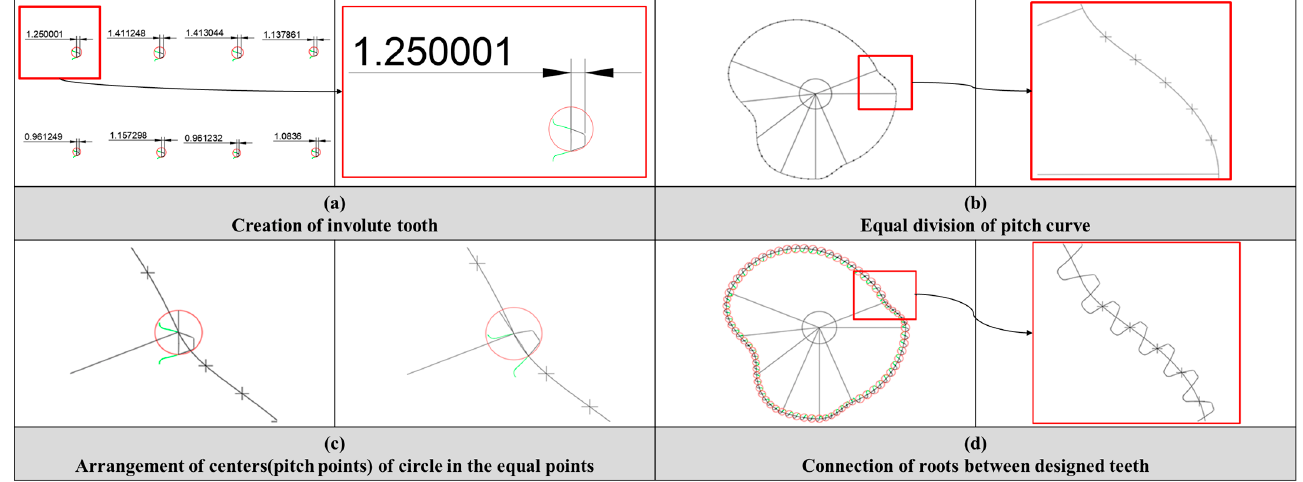
Figure 7. Design procedures of non-circular gear.